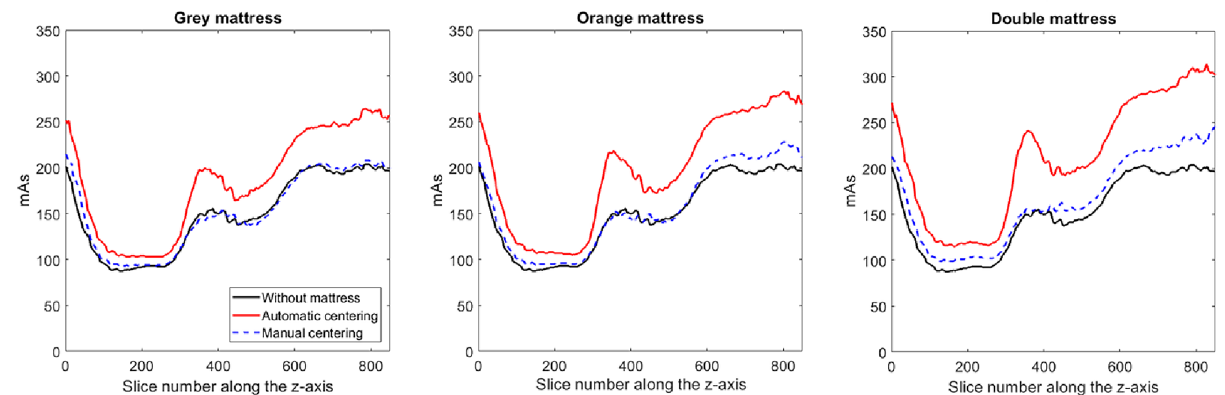
Figure 3. Modulated mAs along the z-axis obtained for image acquisitions without and with additional mattresses after automatic and manual phantom centering. The differences in mAs values along the z axis are related to the differences in anatomical structures in the phantom (shoulder, chest, abdomen,